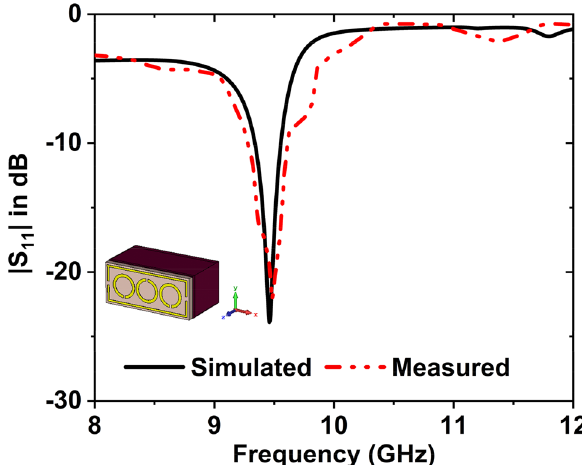
Figure 15. S 11 results when the sample holder is filled with air.